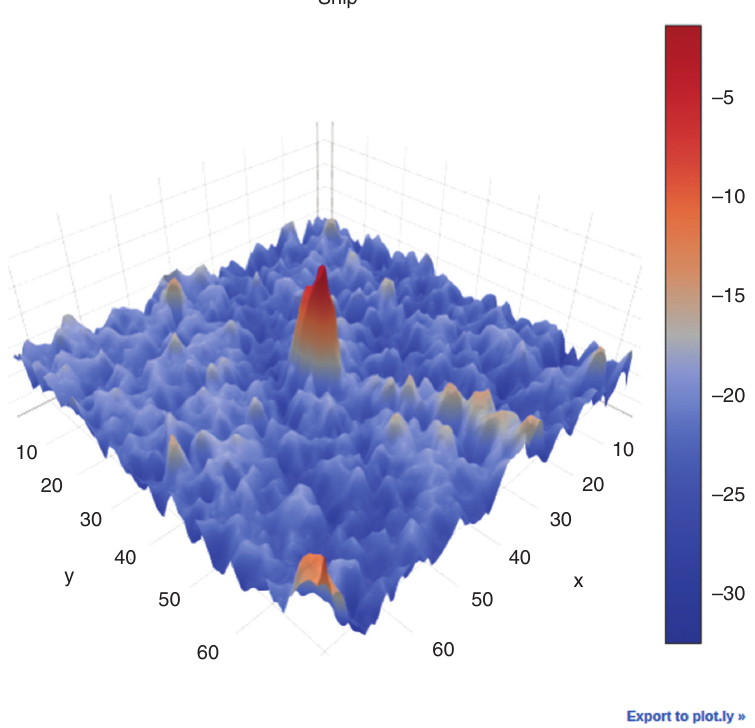
Figure 1: 3D Plot of a Ship.